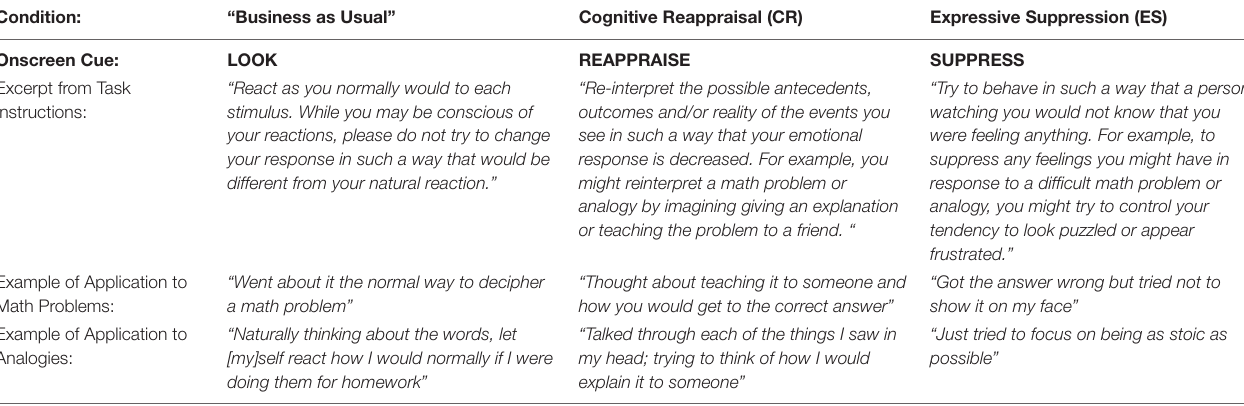
Table comparing different instructed emotion regulation conditions with excerpts from the instructions given to participants as part of the training they received. Participants practiced all techniques with each task: math problems and analogies. In each of the examples, participants told the experimenter how they used the